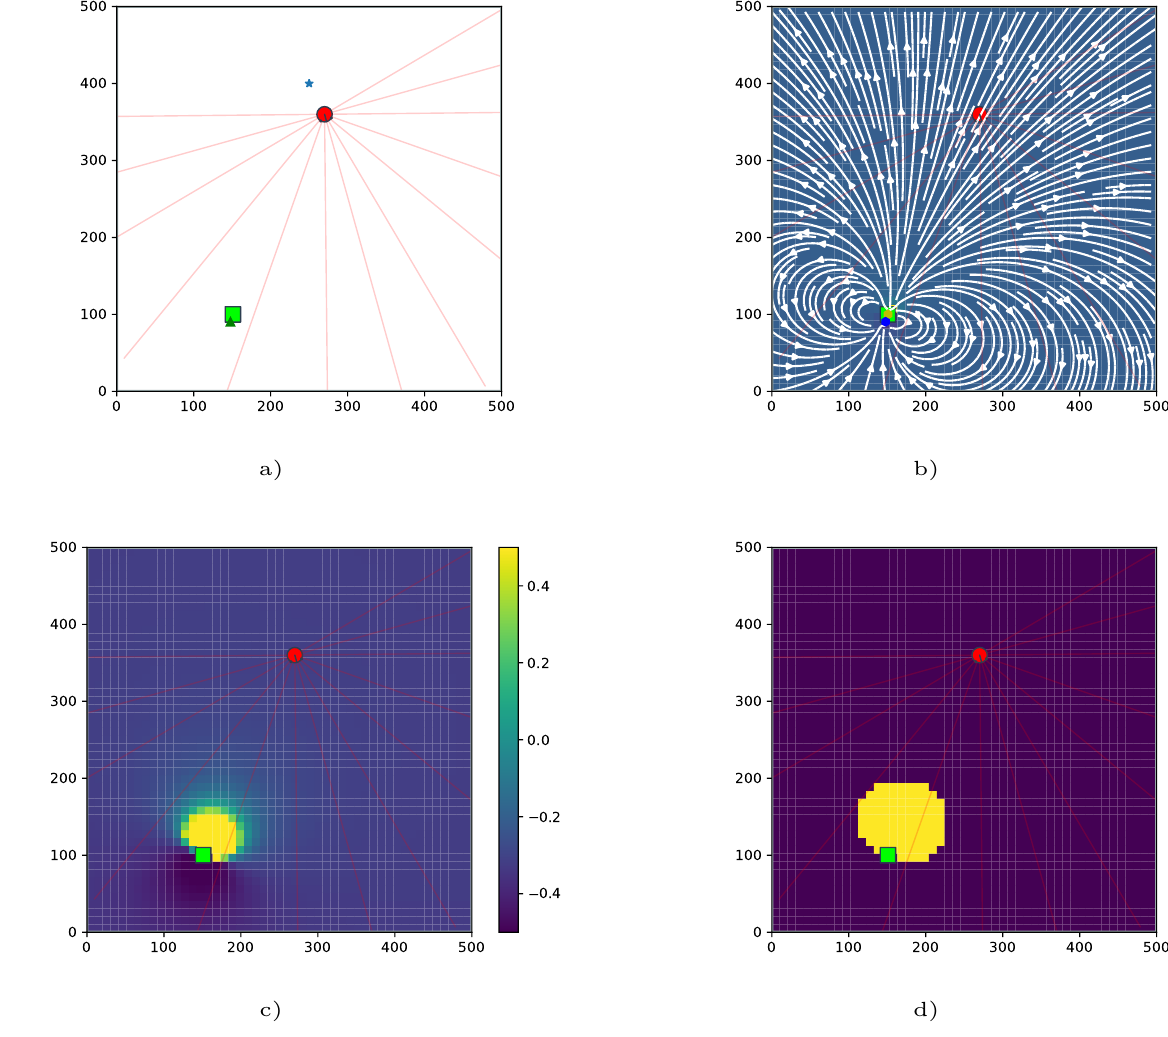
Figure 5. Example of the calculation of forces used for the reward function. Environment units are in cm. ( a ) Initial distribution of the robots. The orientation of each robot and the distribution of its sensors are observed. The target (star) and the box to be moved are also displayed. ( b ) Stream diagram generated by the two forces (repulsive (yellow points) and attractive (blue points)) located in the vicinity of the box for this environment. ( c ) | U | β for β = 60. ( d ) Discretized use of the function, where the threshold values are represented in yellow and (cid:101) = 0.2, such that | U | β > (cid:101)